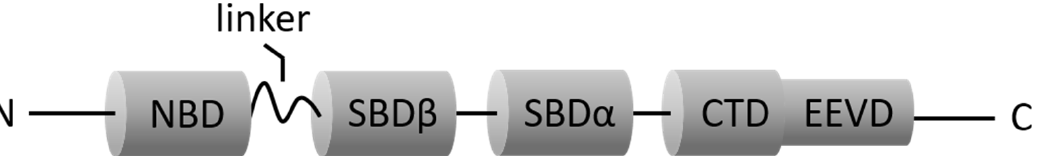
Figure 1. Schematic diagram demonstrating domain organization of HSP70 family. HSP70 family members are composed of highly conserved N-terminal nucleotide-binding domain (NBD) and C-terminal substrate-binding domain (SBD) that are connected by a linker. The latter domain is subdivided into β -sandwich subdomain (SBD β ) and α -helical subdomain (SBD α ), which is followed by a disordered C-terminal domain (CTD) that frequently ends with a charged EEVD motif.